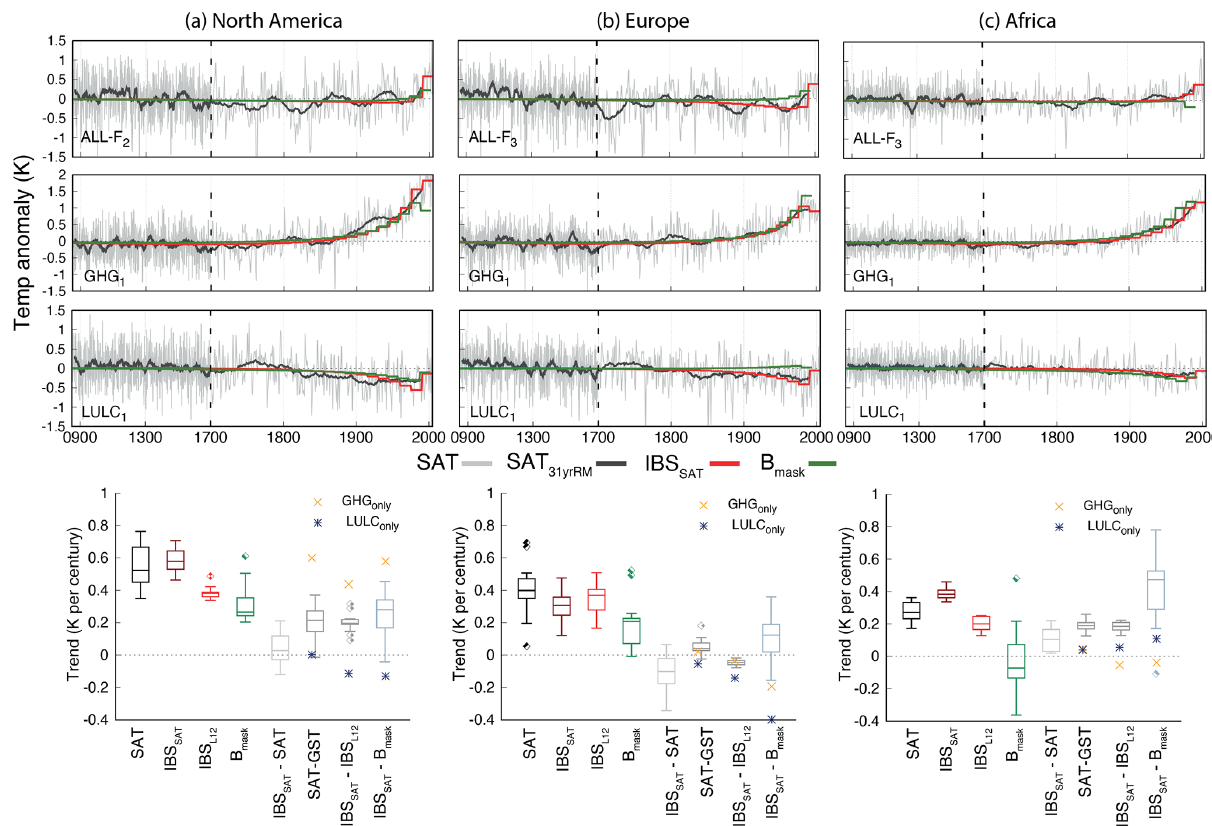
Figure 8. LM regional SAT annual anomalies and the corresponding 31-year filtered outputs and the global IBS SAT and the B mask pseudo- reconstructions for the ALL- F 2 , GHG 1 and LULC 1 (from top to bottom) members of the ALL- F , GHG- and LULC-only ensembles, respectively, (a) North America, (b) Europe and (c) Africa. Note the different discretization in the x axis after 1700CE. Bottom panels as Fig. 6b but for each of the regions